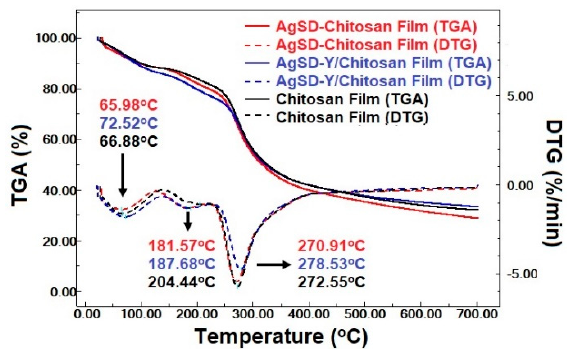
Figure 10. curve for the Chitosan film and AgSD/Chitosan film and AgSD-Y/Chitosan film.